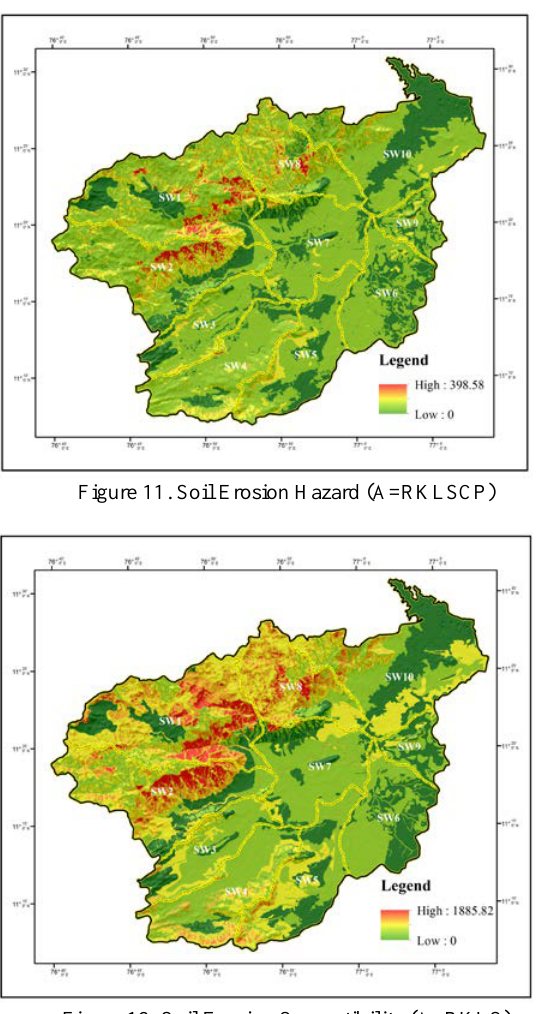
Figure 12. Soil Erosion Susceptibility